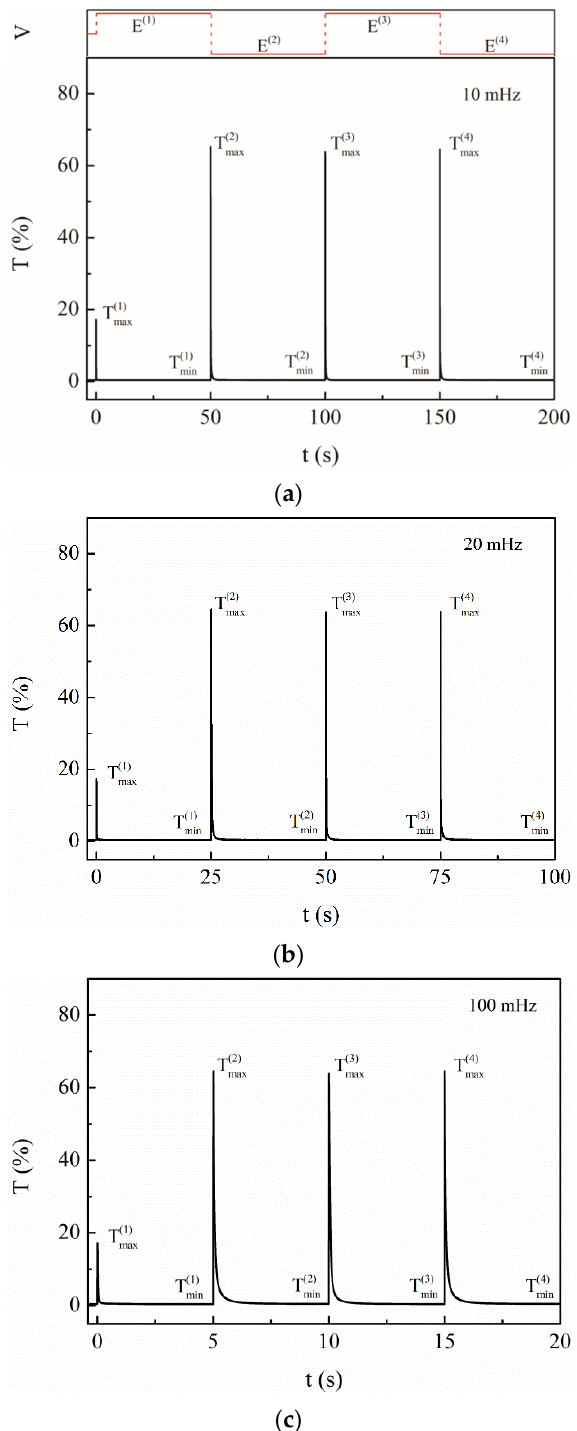
Figure 3. The transmittance changed with time by applying the PDLC sample with the AC square wave voltage at the frequencies of 10 mHz, 20 mHz, and 100 mHz, respectively. E ( 1 ) , E ( 2 ) , E ( 3 ) , and E ( 4 ) correspond to the applied electric fields in four T -periods, respectively. T and 𝑇 correspond, respectively, to the minimum and maximum transmittances in the four T